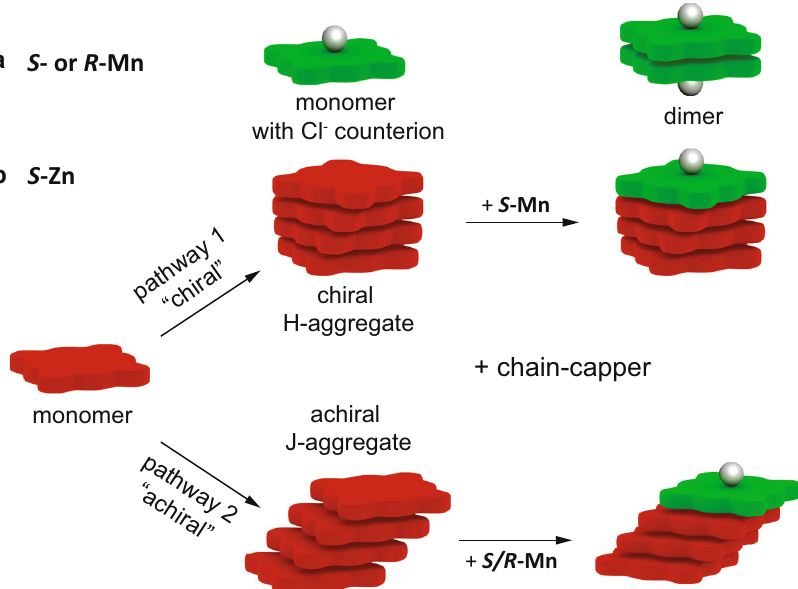
Fig. 2 Aggregate types and pathways for a S -Mn and b S- Zn and co-assembled mixtures thereof. a While S/R -Mn can only be monomeric or form a dimer, ( b ) S -Zn can aggregate via a cooperative mechanism to H-aggregates or via an isodesmic pathway to J-type aggregates. The achiral J-aggregate can be chain-capped by both S- and R -Mn , but the chiral H-aggregate can only interact with S -Mn as a chain-capper, introducing the possibility for enantioselective chain-capping of polymers.